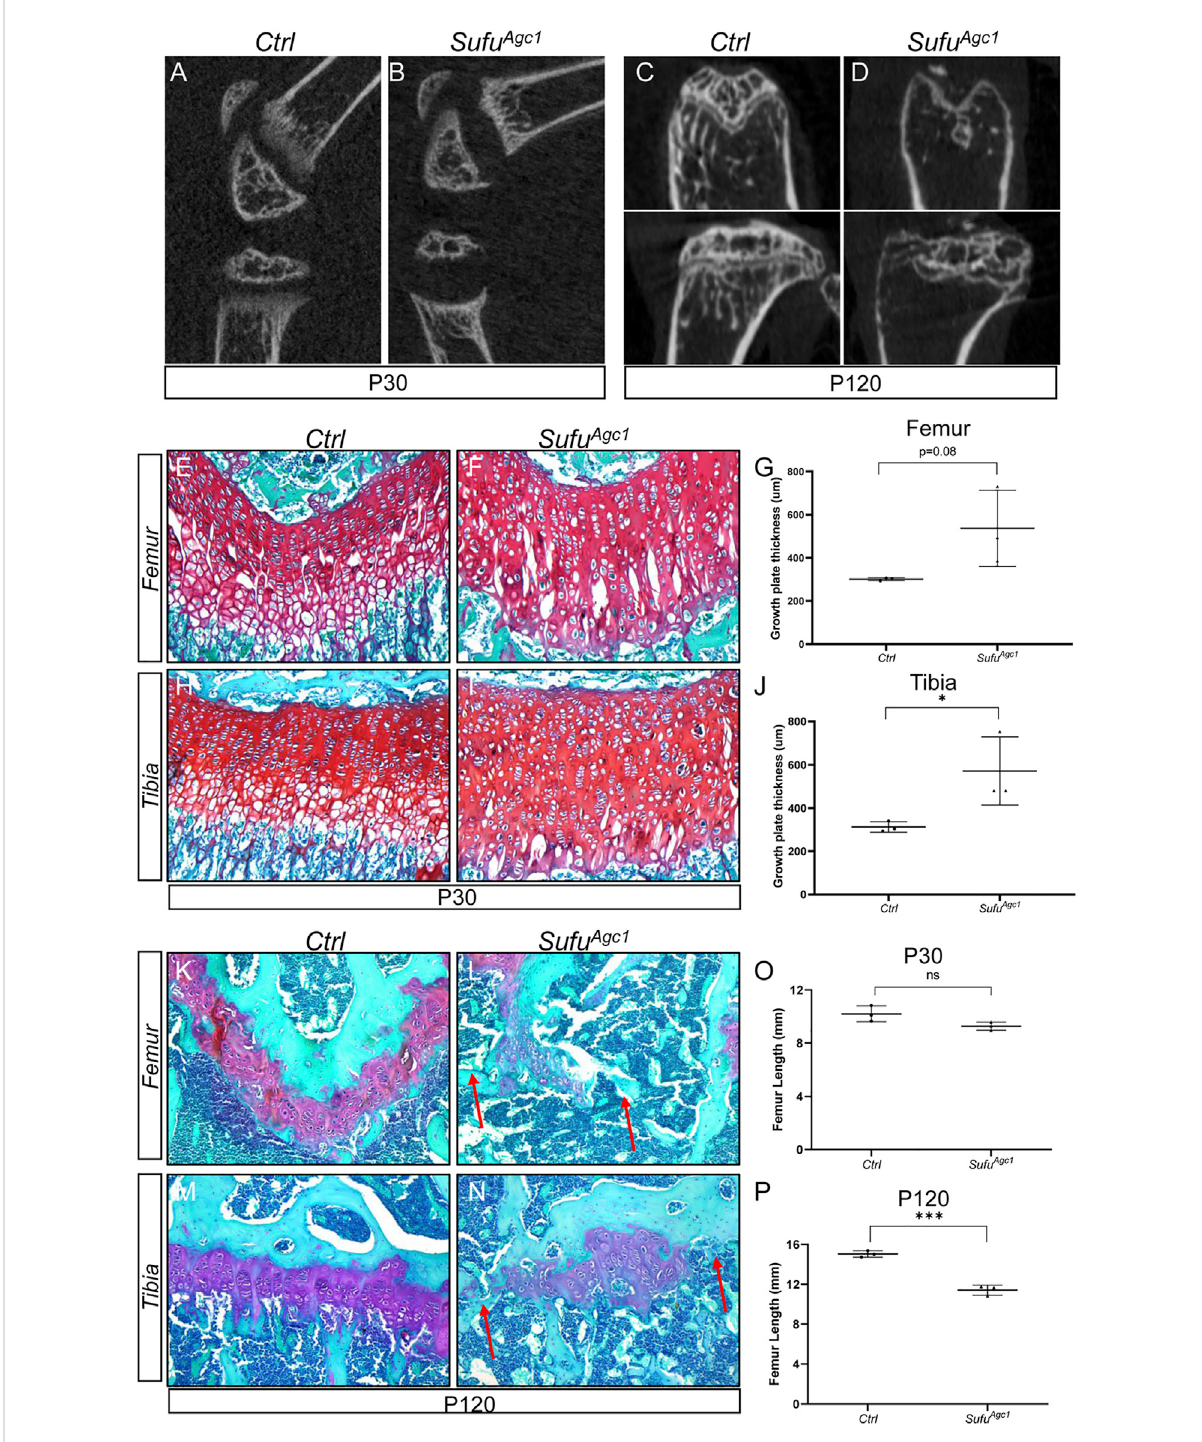
FIGURE 5 Chondrocyte-speci fi cdeletion of Sufu injuvenilemice caused atransient expansion of growth plates followed bytheir premature fusion (A – D) Representative uCT slices of growth plates in Agc1-CreER T2 ; Sufu f/f ( Sufu Agc1 ) (A,C) and control mice ( Ctrl ) (B,D) at P30 (A,B) or P120 (C,D) (E,F) Safranin O staining of distal femoral growth plates from P30 Ctrl and Sufu Agc1 mice (G) Quanti fi cation of average thickness of distal femoral growth platesfromP30 Ctrl and Sufu Agc1 mice (H,I) SafraninOstainingofproximaltibialgrowthplatesfromP30 Ctrl and Sufu Agc1 mice (J) Quanti fi cation of average thickness of proximal tibial growth plates from P30 Ctrl and Sufu Agc1 mice (K – N) Safranin O staining of growth plates in distal femurs (K,L) or proximal tibiae (M,N) from P120 Ctrl and Sufu Agc1 mice. Red arrows indicated the fusion of the growth plates in the mutant distal femurs and proximaltibiae (O,P) .Measurementofaveragelengthsoffemursfrom Ctrl and Sufu Agc1 miceatP30 (O) andP120 (P) .Allquantitativedatawereshown as individual data points from each mouse together with mean ± standard deviation. p values were obtained by Student ’ s t-test and degrees of statistical signi fi cance were designated by different numbers of asterisk (*) in the fi gures: *, p < 0.05 ; **, p < 0.01 ; ***, p < 0.001 ; ****, p < 0.0001 .